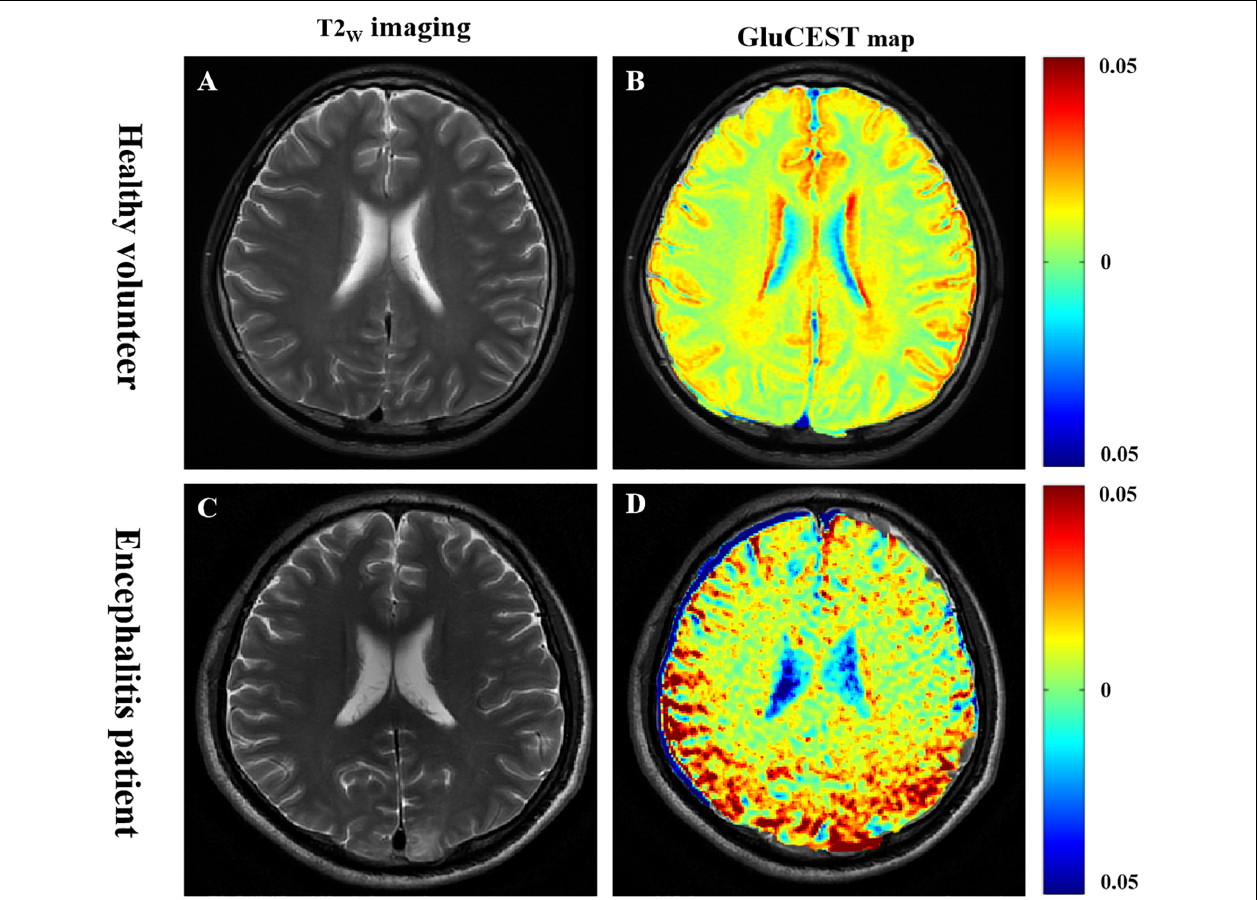
FIGURE 3 | Glutamate chemical exchange saturation transfer imaging was feasible in human brain using the 3.0 T MR system. (A,B) In a healthy volunteer, GluCEST magnetic resonance image (MRI) could clearly distinguish white matter and gray matter, similar to T2 W imaging, and the gray matter signal intensity of GluCEST was higher than that of white matter. (C,D) In a patient with encephalitis, GluCEST imaging also clearly showed the left parietal cortex and subcortex